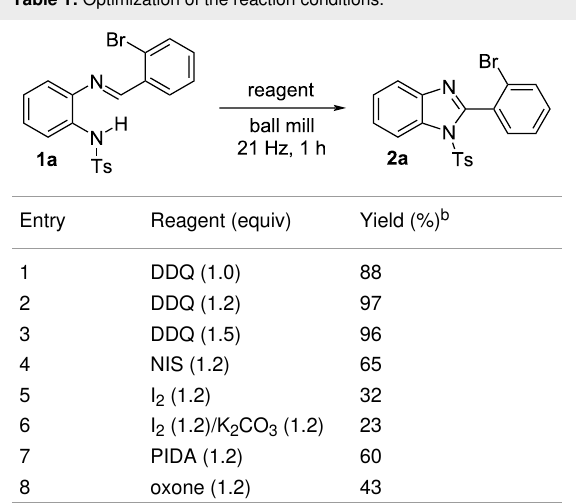
Table 1: Optimization of the reaction conditions.